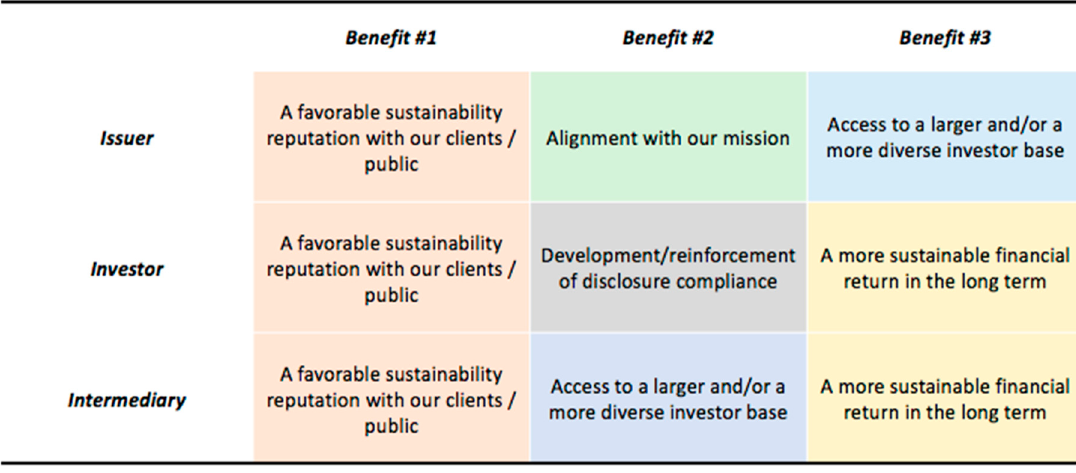
Figure 6. Top three benefits of the green bonds for each category of market participants. Source: interviews with 11 experts across issuers, investors, and intermediaries, conducted in December 2019.